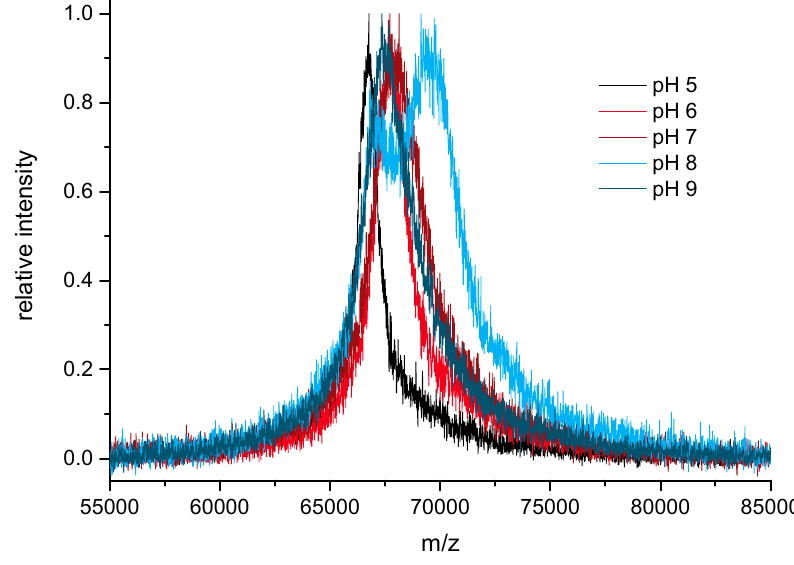
Figure 3. Influence of pH on activation level at constant SIA excess.